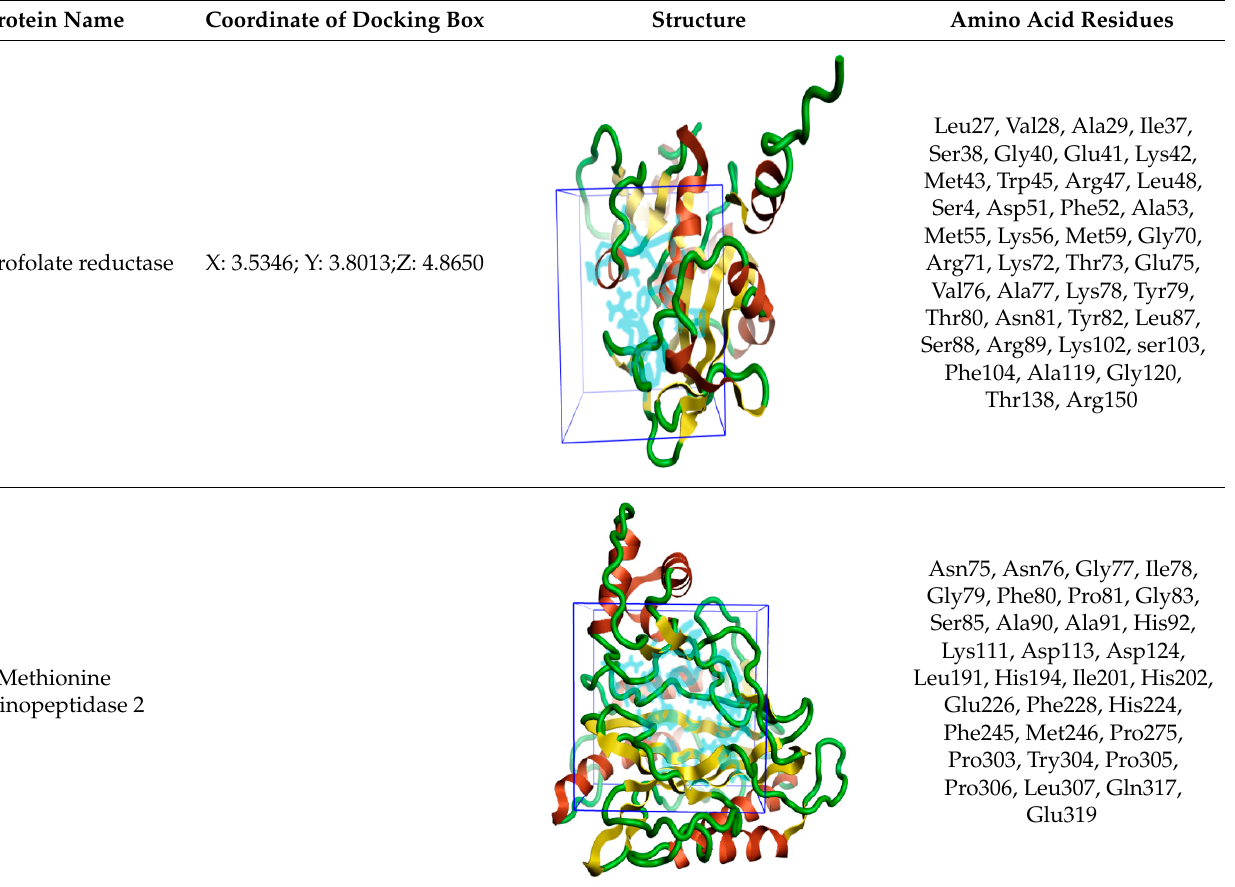
Table 2. Total amino acid residues present in the binding pockets of different proteinsofEHP and L. vannamei.